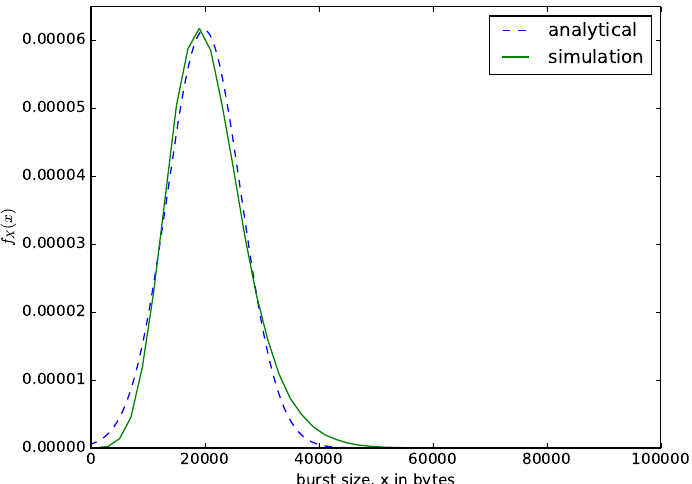
Figure 9. The distribution of the size of the aggregated packet in bytes for a time-based packet aggregation mechanism.